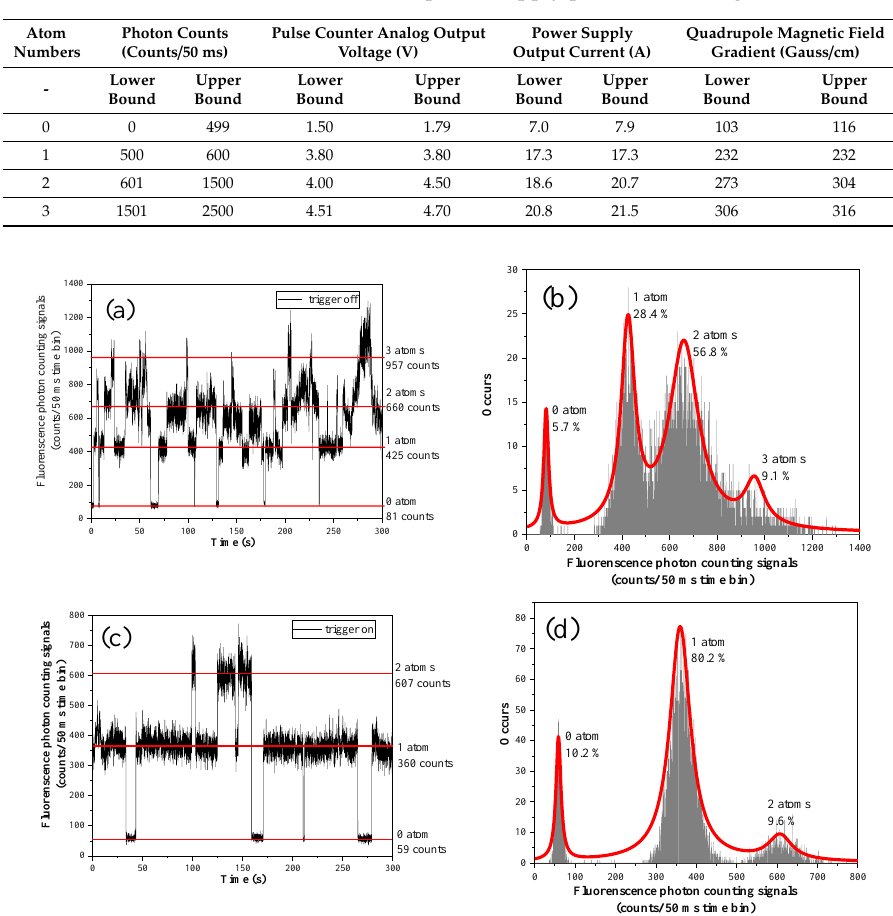
Figure 3. The loading probability of single-atom in the MOT. The trigger loop can suppress the probability of multi-atom in the MOT and improve the probability of single-atom. ( a , b ) When the trigger loop turned off, the loading probability of single-atom in the MOT within 300 s is only 28.4%, and the probability of multiple-atom and zero-atom is as high as 71.6%, which is obviously not conducive to the measurement in subsequent experiments. ( c , d ) For the trigger loop on, the probability of single-atom in the MOT increases to 80.2%, while the probability of multi-atom loading is significantly suppressed.